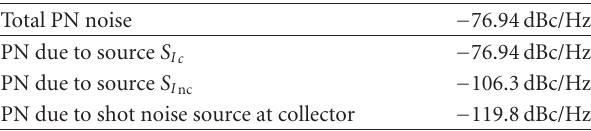
Table 4: Contribution of elementary noise sources to total phase noise at 100 kHz from the